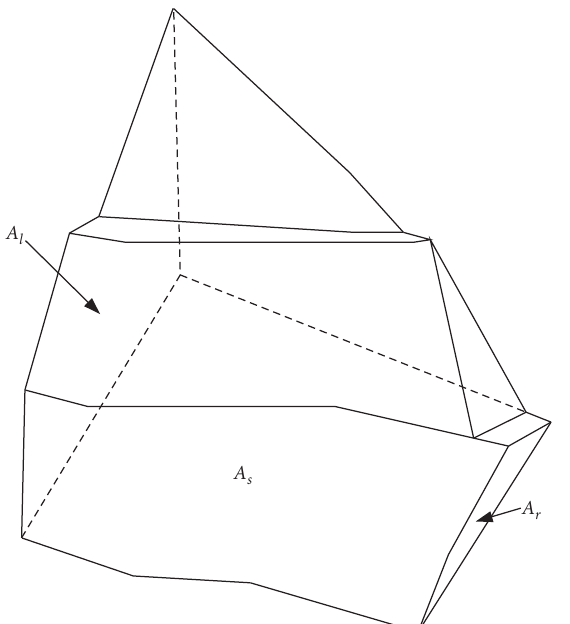
Figure 16: The schematic of the failure block for LEM